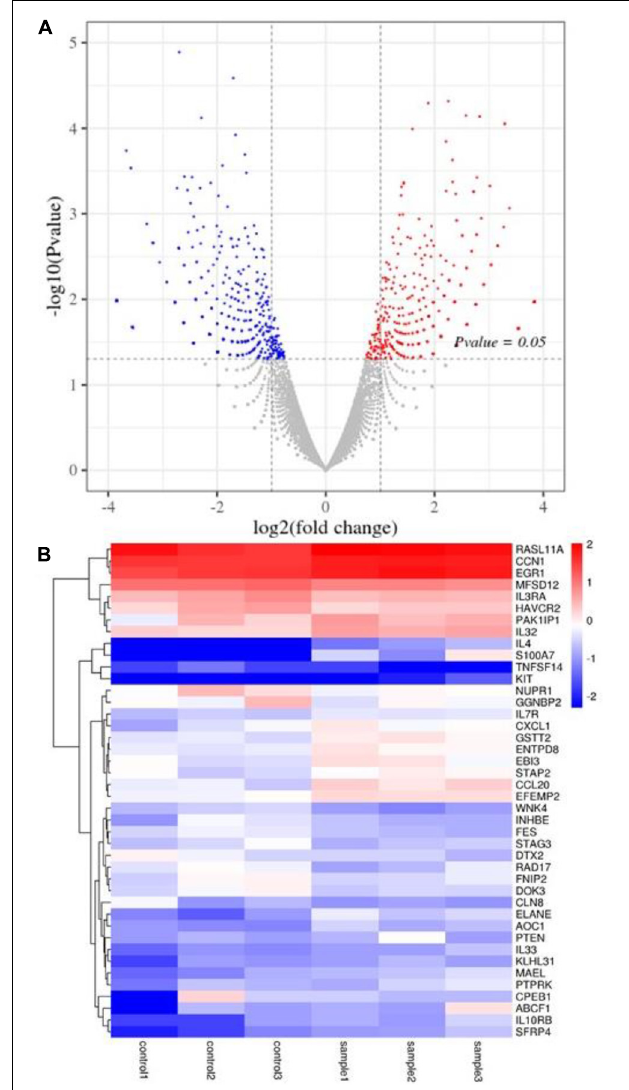
FIGURE 6 | DEG analysis of HT-29 cells treated with L. acidophilus ( n = 3). (A) The volcano plot of a differential gene. (B) Clustering heatmap of differentially expressed gene expression. Controls 1, 2, and 3 were nontreated with L. acidophilus in HT-29 cells. Samples 1, 2, and 3 were treated with L. acidophilus of MOI 100 for 48 h in HT-29 cells. The red dots in the differentially expressed gene volcano map represent up-regulated, differentially expressed genes; blue dots represent down-regulated, differentially expressed genes, and gray dots represent non-differentially expressed genes. The heatmap expresses cancer-related genes, where red represents genes with high log2 (FPKM/average FPKM) expression, and blue represents low